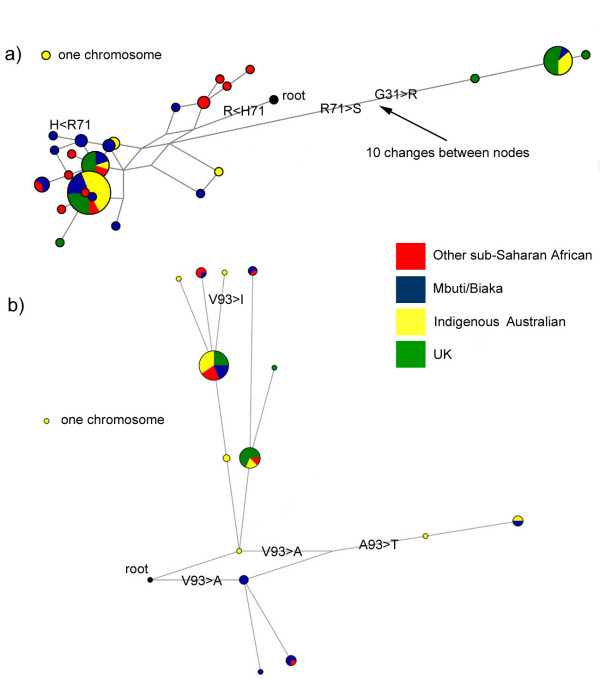
Network diagram of haplotypes. Pie size is proportional to number of observations of each haplotype. The number on each branch reflects the polymorphic site, as indicated in supplementary tables 3 and 4. Branches that change an amino acid are also highlighted with that change. a) DEFB127. b) DEFB132.